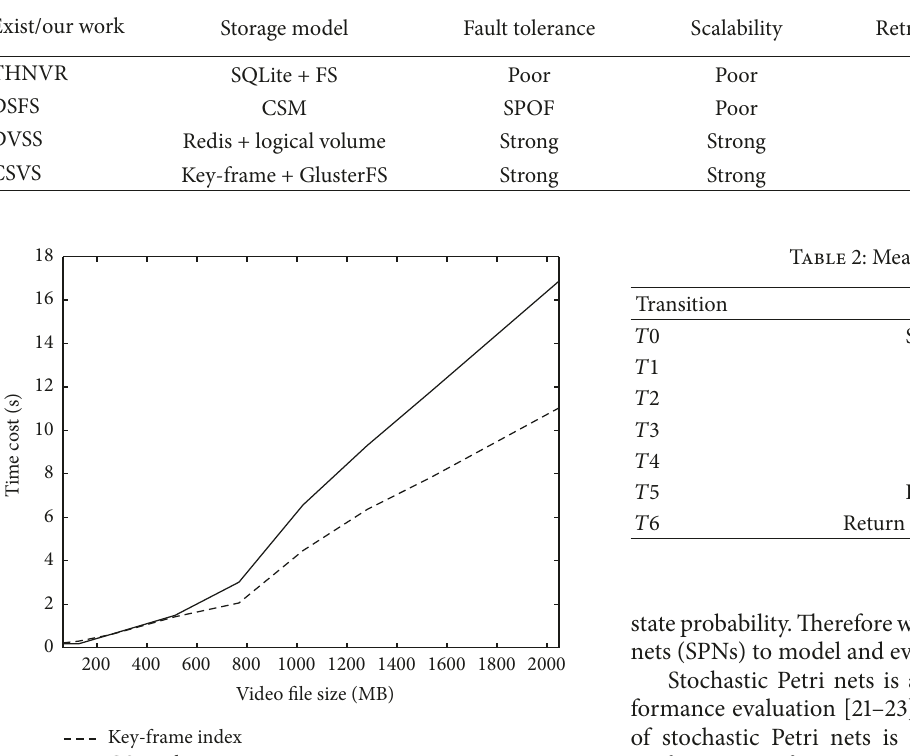
Figure 5: Comparison of retrieval time.